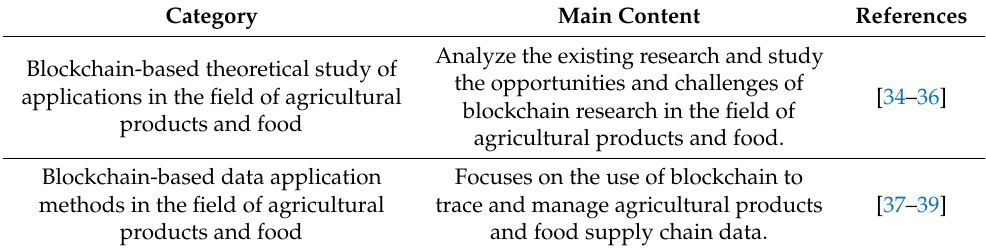
Table 1. Literature review